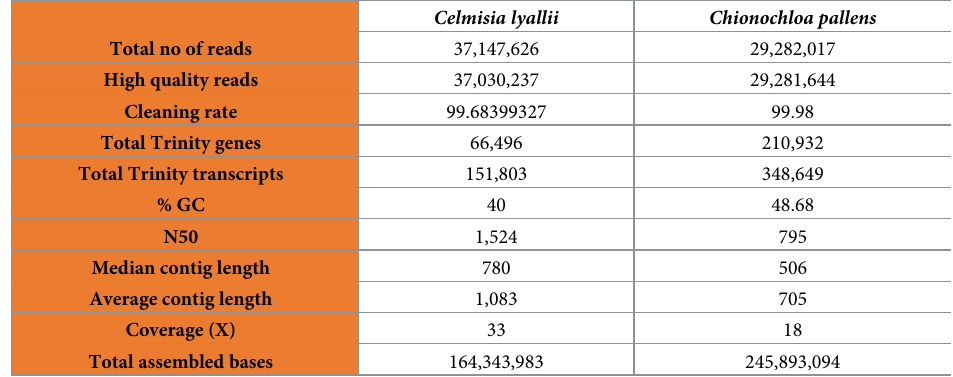
Table 1. Assembly statistics for the de novo